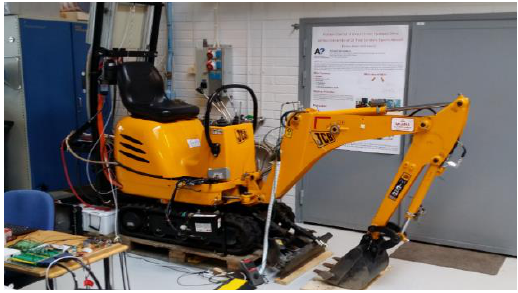
Figure 5. The micro-excavator in the laboratory.